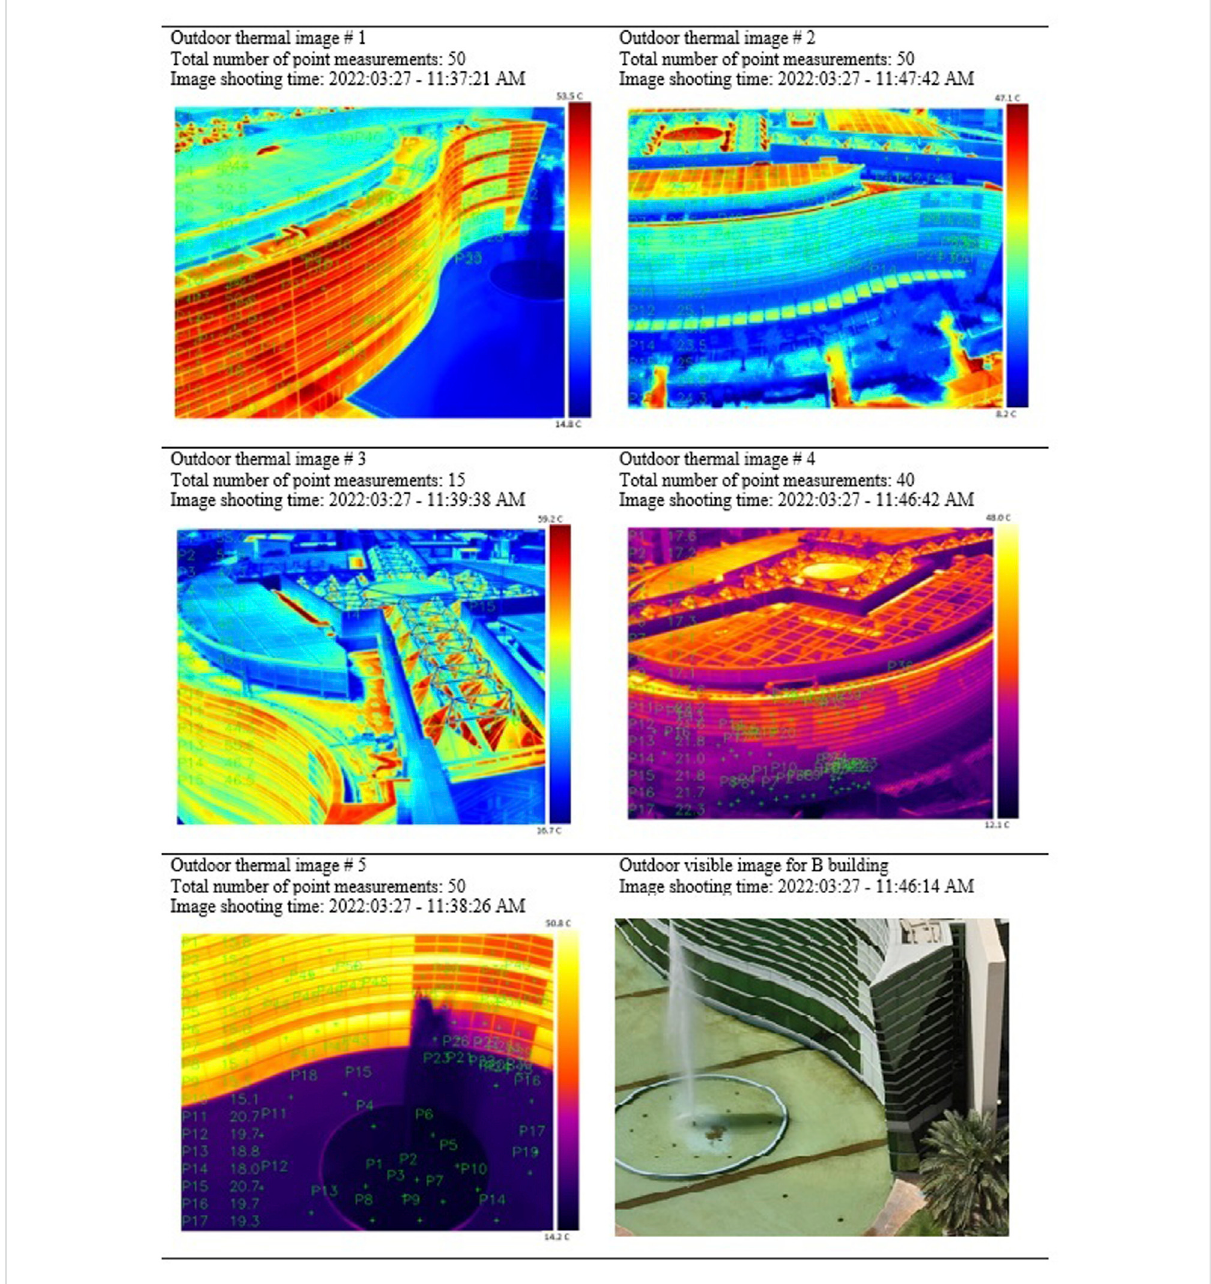
FIGURE 5 Thermal imaging measurements for the B outdoor